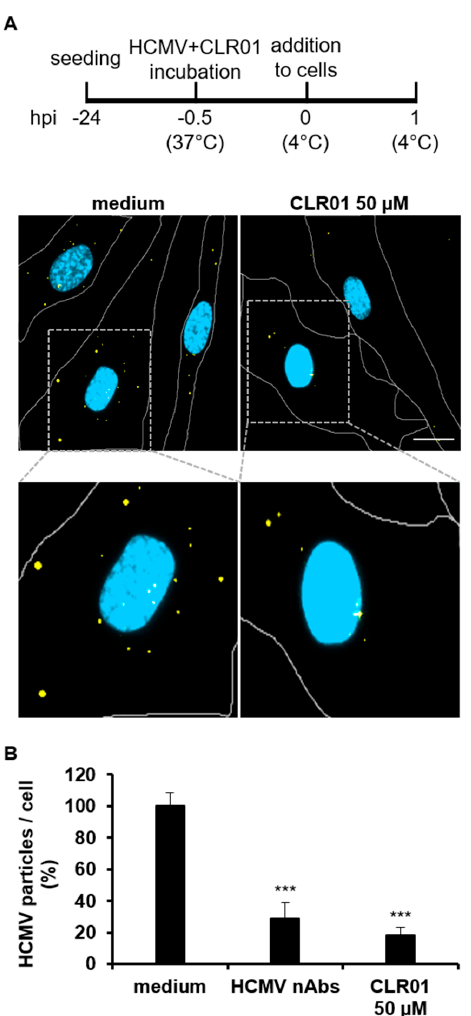
Figure 2. CLR01 reduces the attachment capacity of HCMV particles. ( A ) Cell-free virus particles of a fluorescent-tagged HCMV were incubated with 50 µM CLR01 and medium for 30 min at 37 °C. Attachment of virus particles to human fibroblasts was allowed for 1 h at 4 °C. Blue, DAPI-stained cell nuclei; yellow, cell-bound HCMV particles; and white, cell borders. Scale bar is 5 µ m. ( B ) Quantification from A with neutralizing antibodies (nAbs, 5 mg/mL Gamunex) as an additional control. Number of attached HCMV particles per cell was determined for at least 100 cells for each condition from two individual experiments. Means ± SDs of relative numbers of attached HCMV particles per cell. Controls (medium) were set to 100% and samples normalized accordingly. ***, p <